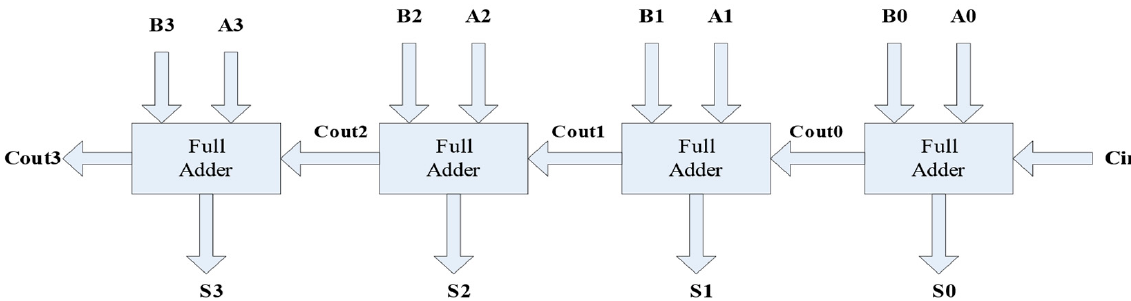
Figure 4. A 4-bit ripple carry adder.